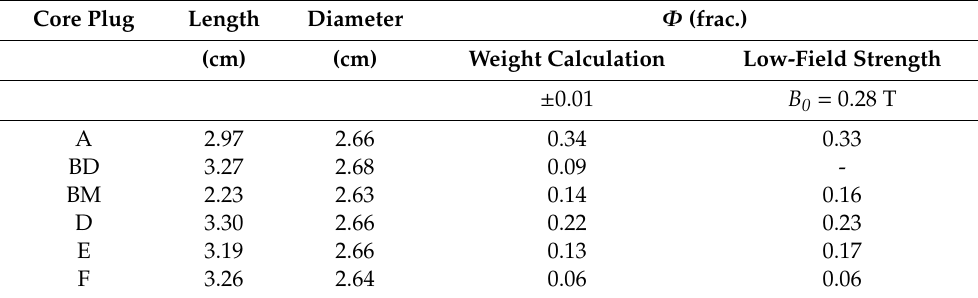
Table 2. Porosity of each core plug estimated by weight calculations and transverse relaxation distributions at low magnetic field strength.